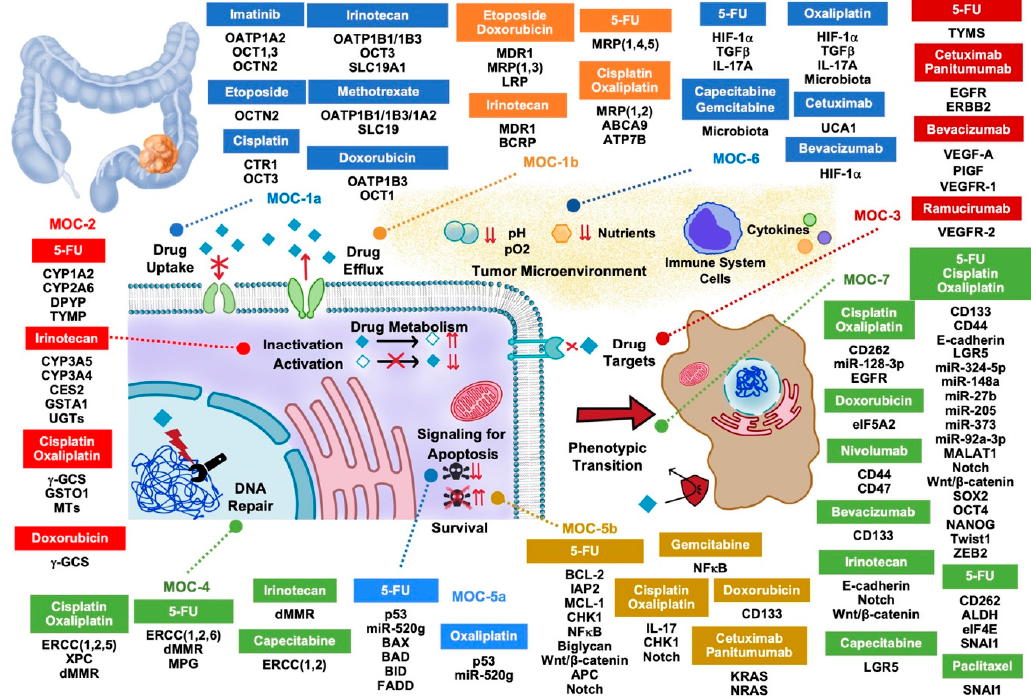
Figure 1. Proteins, non-coding RNAs, and signaling pathway regulators involved in the lack of response of colorectal adenocarcinoma to pharmacological treatment. MOC, mechanism of chemoresistance.